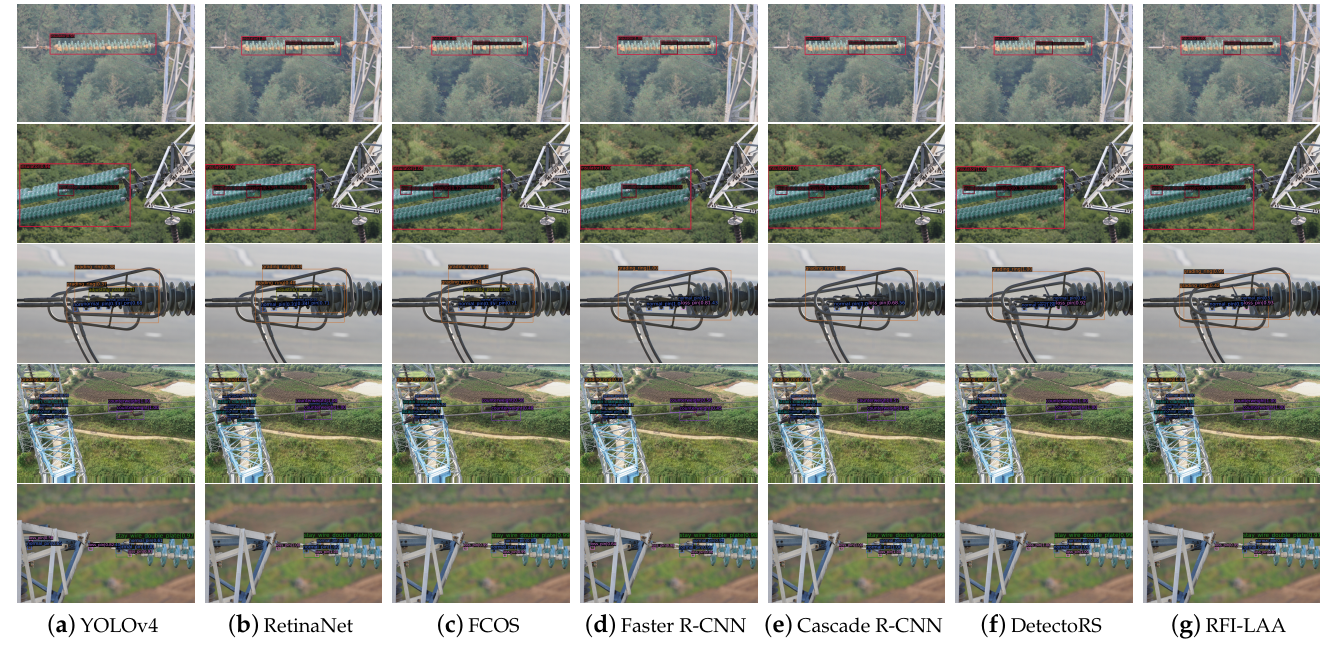
Figure 10. Comparison of visual detection